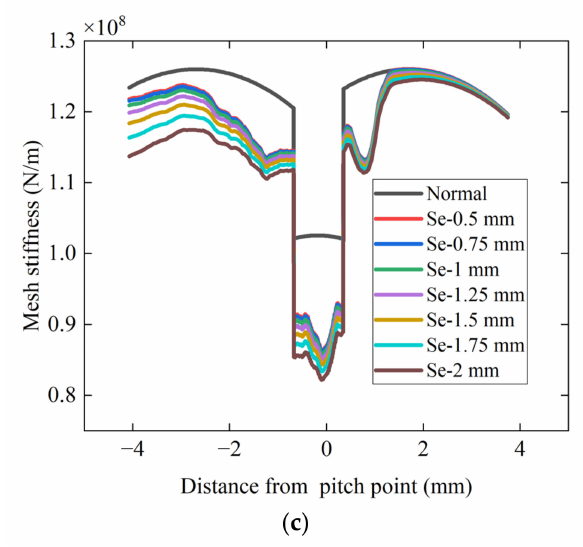
Figure 10. The crack effect on meshing stiffness with different degrees of pitting: ( a ) The time-varying meshing stiffness of gear teeth with slight pitting and different crack depth; ( b ) The time-varying meshing stiffness of gear teeth with moderate pitting and different crack depth; ( c ) The time-varying meshing stiffness of gear teeth with severe pitting and different crack depth.